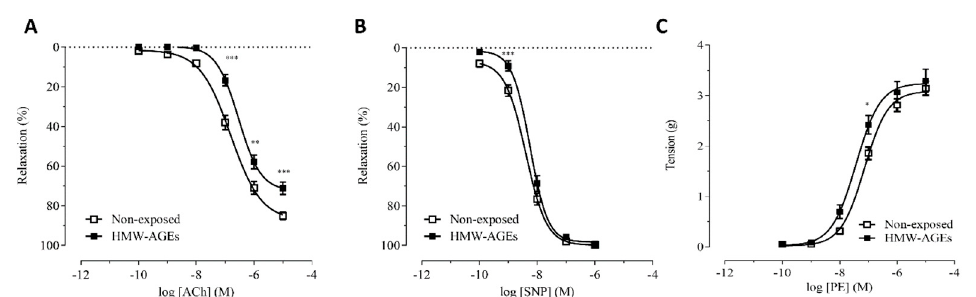
Figure 1. Vasorelaxation and vasocontraction response after acute HMW-AGEs exposure in isolated rat aortic rings. Relaxation response is expressed as the percentage relaxation relative to phenylephrine-induced (final bath concentration: 10 − 7 M) precontraction. ( A ) Relaxation response to cumulative doses of acetylcholine (ACh, final bath concentrations: 10 − 10 –10 − 5 M) in aortic rings left non-exposed ( n = 48, N = 15) or preincubated with HMW-AGEs ( n = 24, N = 13). ( B ) Relaxation response to cumulative doses of sodium nitroprusside (SNP, final bath concentrations: 10 − 10 − 10 − 6 M) in aortic rings left non-exposed ( n = 47, N = 12) or preincubated with HMW-AGEs ( n = 23, N = 12). ( C ) Contractile response to cumulative doses of PE (final bath concentrations: 10 − 10 –10 − 5 M) in rat aortic rings which were left non-exposed ( n = 18, N = 4) and preincubated with HMW-AGEs ( n = 7, N = 4). The sample size is indicated as ‘n’ (number of aortic rings) or ‘N’ (number of rats). Data points are visualised as mean ± SEM. * p < 0.05, ** p < 0.01 and *** p < 0.001. Table 1. E max and logEC 50 values in isolated rat aortic